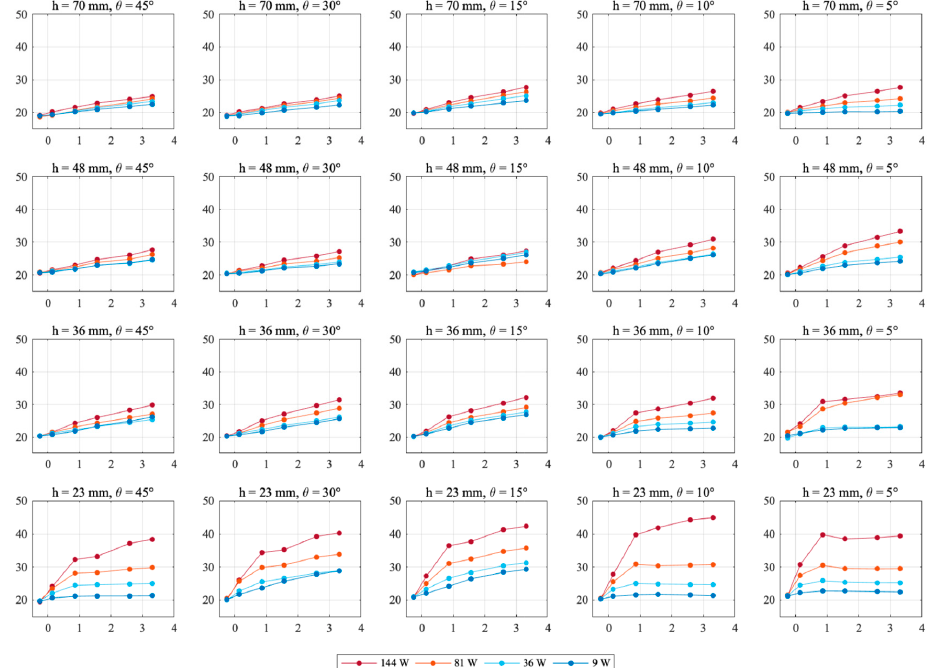
Figure A1. Temperatures (°C) (y-axis), in the cavity air as a function of distance (m) from the cavity inlet (x-axis). Each plot represents a given air cavity height (h) and roof inclination ( θ ).